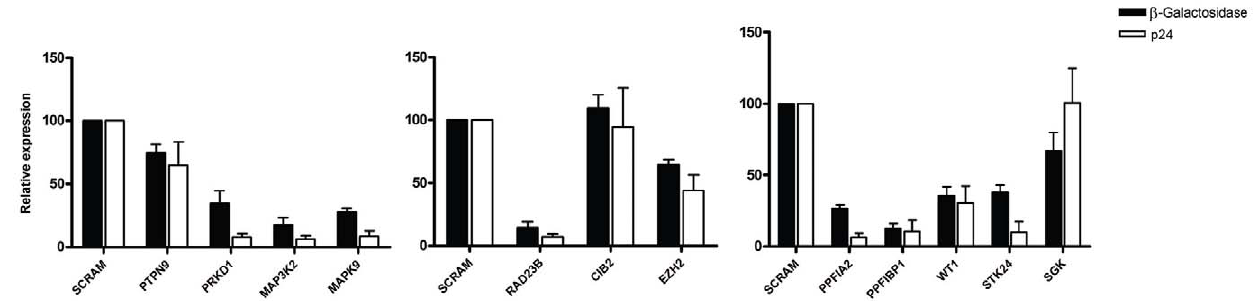
Figure 5. HIV-1 LTR-driven transcription is affected by host-proteins. Transient assays were performed in HeLa-P4 cells co-transfected with pHIV-1 NL4-3 and the different shRNA plasmids. After 48 h, cells were harvested and LTR transcription was measured by quantification of the b - Galactosidase activity in cell lysates. Cell supernatant was also collected to measure viral production by p24 CA ELISA. Black bars indicate values for measurements of b -Galactosidase activity in cell lysates and white bars indicate values for measurements of p24 CA in the supernatant. Values are relative to the control shSCRAM and represent mean 6 SEM ( n =3).